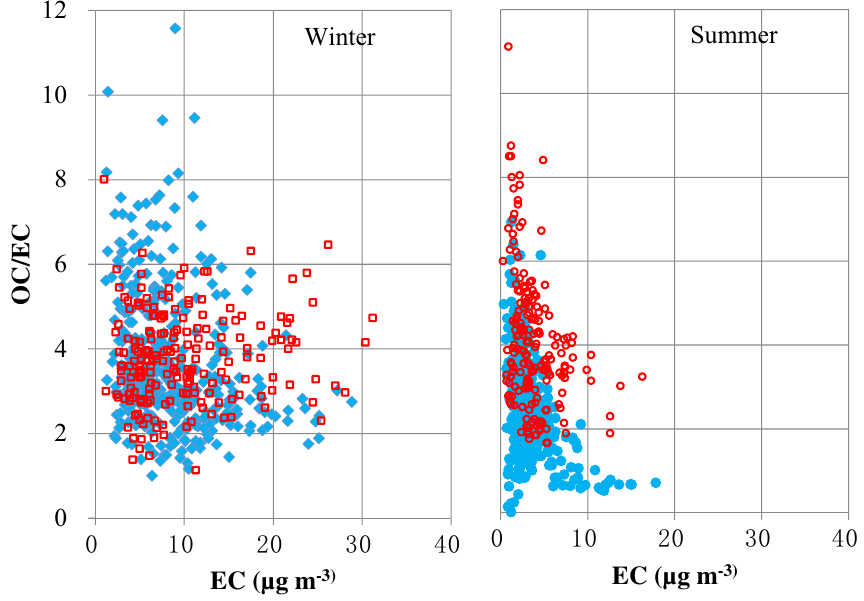
Figure 4. Distribution of OC/EC ratios versus EC concentrations in winter and summer of 2013 (filled blue diamonds) and 2003 (empty red